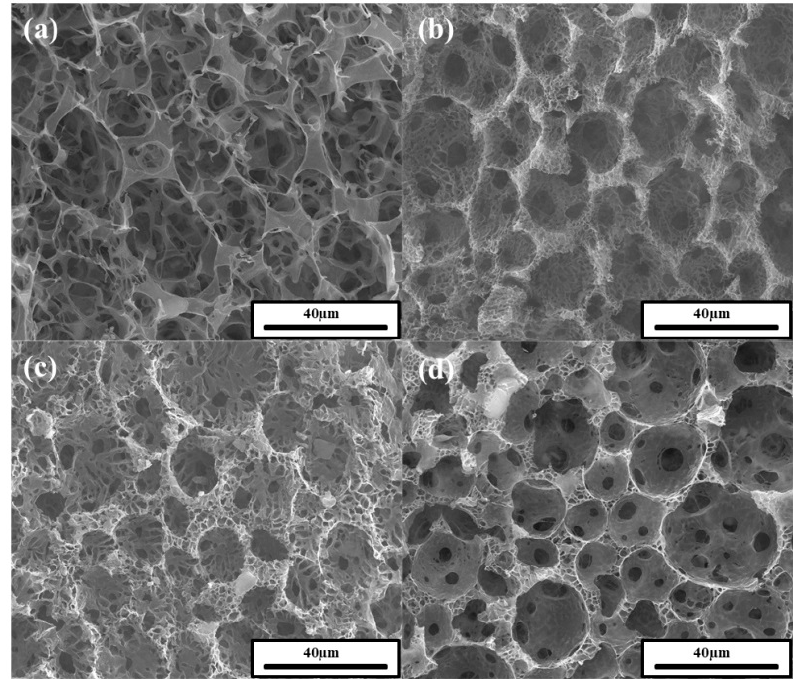
Figure 8. SEM images of polyHIPEs prepared at a 5 wt.% oligoimide particle concentration and 80 vol.% internal phase with PAAS concentrations of ( a ) 2 wt.%, ( b ) 4 wt.%, ( c ) 6 wt.%, and ( d ) 8 wt.%.